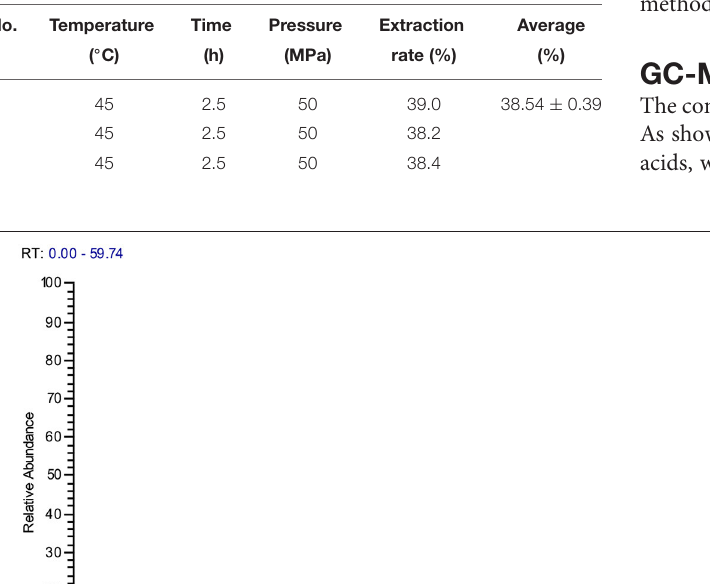
TABLE 4 | Results of the verification test.